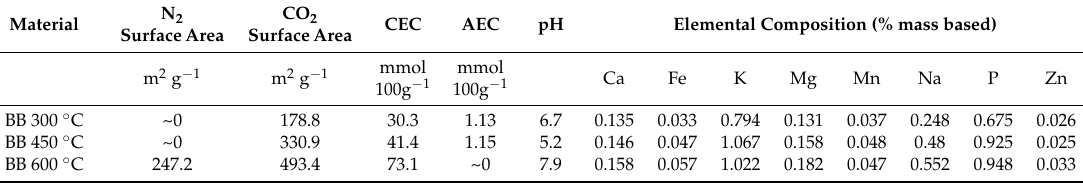
Table 1. Basic physicochemical properties of Bamboo Biochar (BB) produced at 300 ◦ C, 450 ◦ C, or 600 ◦ C. N 2 CO 2 Material CEC AEC pH Elemental Composition (% mass based) SurfaceArea SurfaceArea mmol mmol Ca Fe m 2 g − 1 m 2 g − 1 100g − 1 100g − 1 BB 300 ◦ C